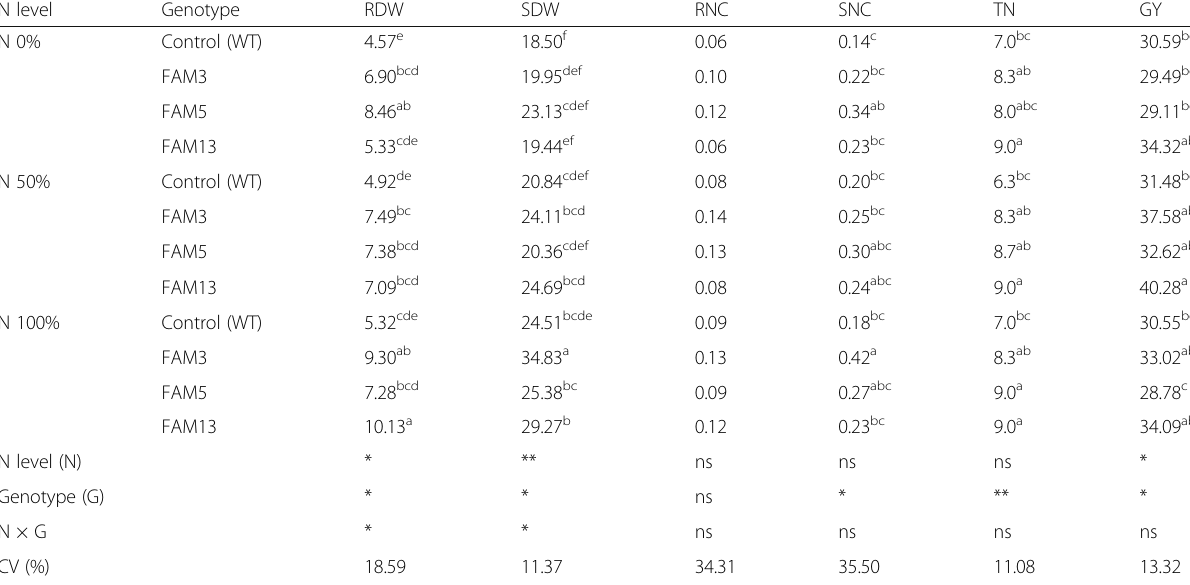
Table 2 Yield parameters measured from greenhouse experiment of three CsAlaAT2 lead events and WT under three N fertilizer regimes N level